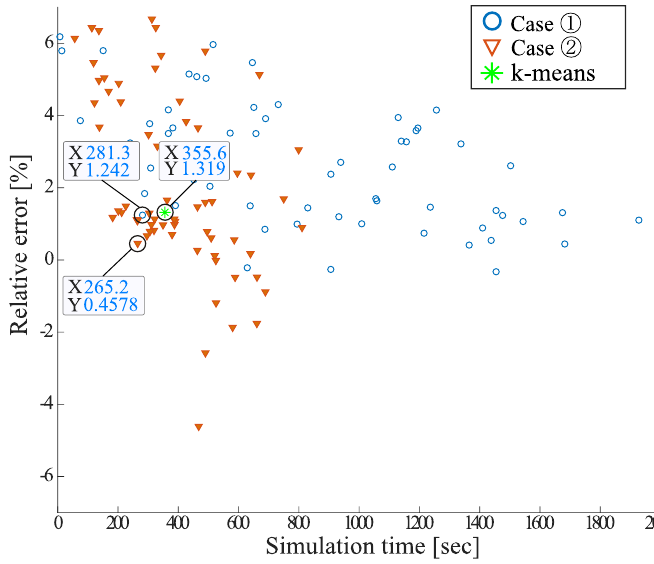
Figure 23. Compare of each result.